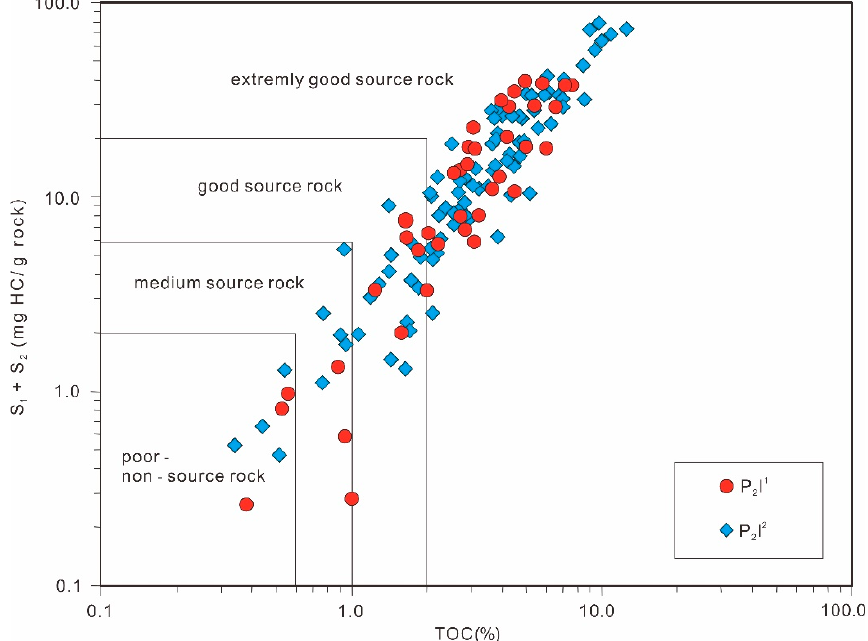
Figure 7. TOC vs. S 1 + S 2 diagram showing the abundance of organic matter in the P 2 l source rocks in the Jimsar Depression (extremely good source rock; good source rock; medium-grade source rock; poor-non-source rock).